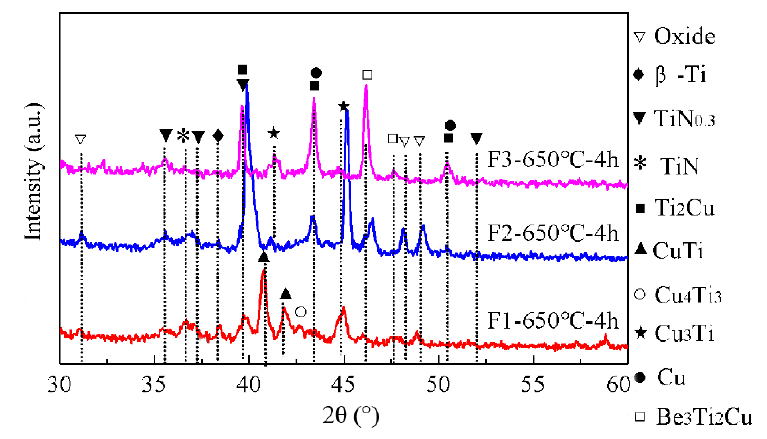
Figure 6. GIXRD results of the Cu-Ti film after plasma nitriding at 650 °C for 4 h.